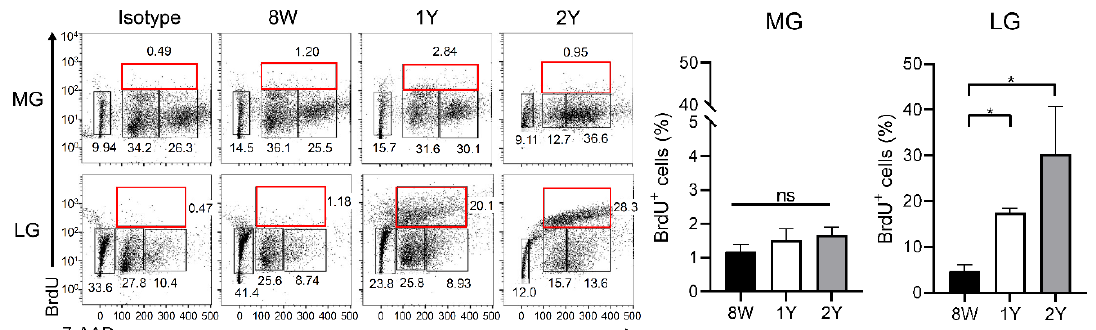
Figure 8. BrdU / 7-AAD cell cycle analysis by flow cytometry. We excluded the apoptotic cells and gated 2n to 4n BrdU + cells by 7-AAD gating. The percentage of BrdU + (2n to 4n) cells in the MGs was not different among the groups (one-way ANOVA; n = 9, 5, and 3 for 8W-, 1Y-, and 2Y-old mice, respectively); however, the percentage of BrdU + cells in the LGs was significantly higher in aged mice (1Y- and 2Y-old mice) than in 8W-old mice ( p = 0.014 and 0.017, respectively; Kruskal–Wallis test followed by Dunn’s post hoc test; n = 9, 5, and 3 for 8W-, 1Y-, and 2Y-old mice, respectively). Red boxes indicate 2n to 4n BrdU + cells. * p < 0.05. Data are presented as means ± standard error.